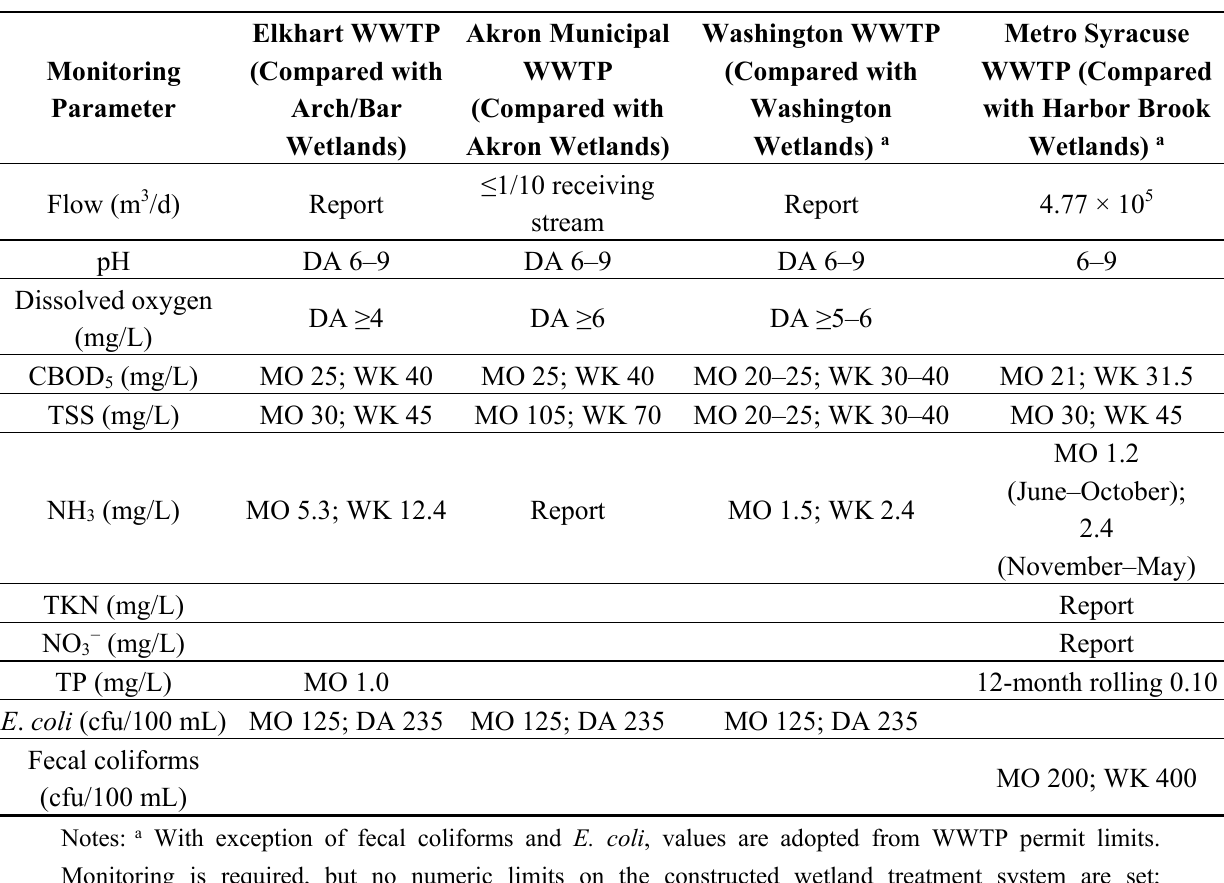
Table 4. Current permit limits for the main outfall of centralized wastewater treatment plants with off-plant CSO constructed wetlands in the